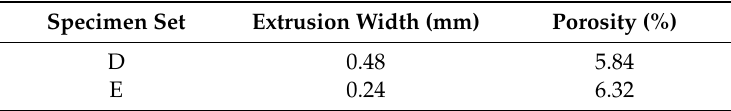
Table 5. Porosity results for specimens with various extrusion widths and the raster orientation selected as 0 ◦ / 90 ◦